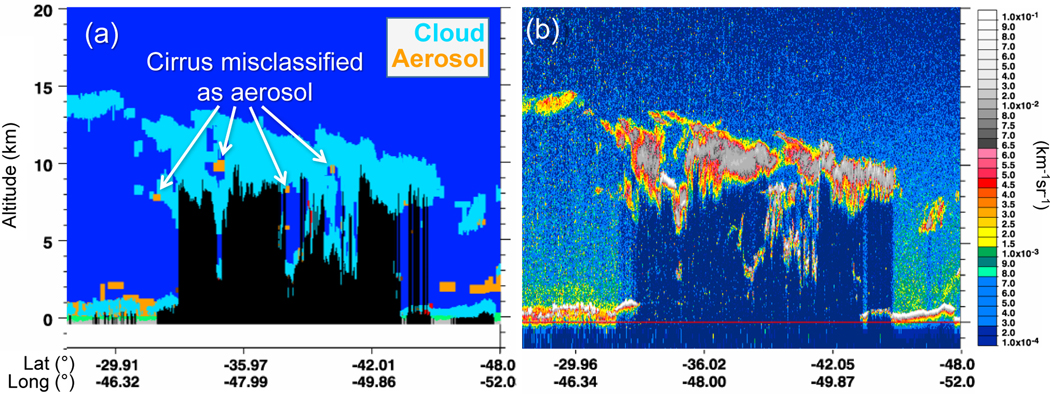
(a) Feature type classification and (b) total attenuated backscatter showing cirrus misclassified as aerosol for the version 3 granule 2011–11-10T03–54-52ZN.